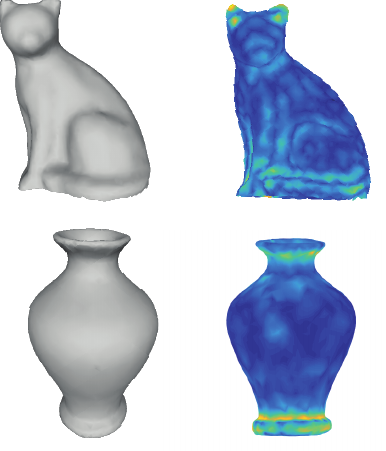
Figure 1. Three-dimensional meshes and their corresponding mesh saliency: ( left ) original 3D meshes; ( right ) 3D mesh